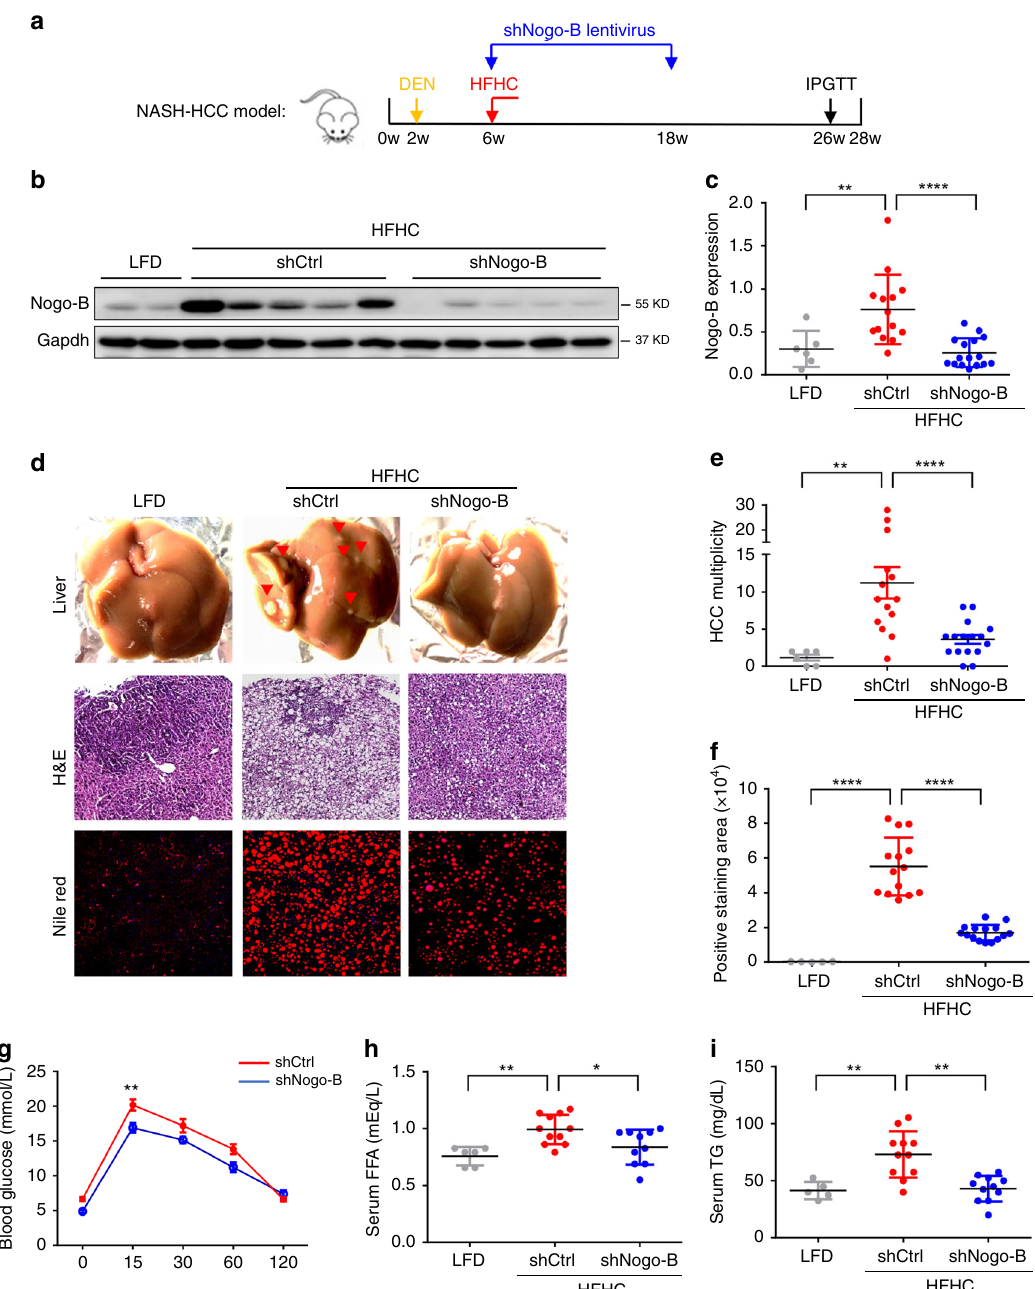
Fig. 3 Knockdown of Nogo-B inhibits NASH and HCC progression. a Scheme of HFHC-promoted NASH-associated HCC model. b , c Representative ( b ) western blot images and ( c ) quanti fi cation of Nogo-B expression in the livers of DEN-treated and, LFD- or HFHC-fed mice administered with lentivirus expressing shCtrl or shNogo-B. Mice were sacri fi ced at 28 weeks of age. LFD/shCtrl: n = 6, HFHC/shCtrl: n = 14, HFHC/shNogo-B: n = 16. d Representative liver pictures (top), H&E staining (middle) and Nile red staining (bottom) in the livers of LFD- and HFHC-fed mice with lentivirus administration. e The average tumor multiplicity of LFD- and HFHC-fed mice described in c . f The percentages of positively stained Nile red areas in the livers of LFD- and HFHC-fed mice described in c . g Blood glucose of 26-week-old HFHC-fed mice at indicated time-points after glucose injection in IPGTT analysis ( n = 12 in each group). h , i Serum h FFA and i TG concentrations of LFD- and HFHC-fed mice described in c . (* p < 0.05, ** p < 0.01, **** p < 0.0001. Source data are provided as a Source Data fi